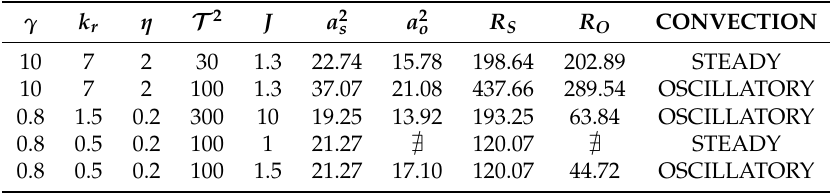
Table 3. Onset of steady or oscillatory